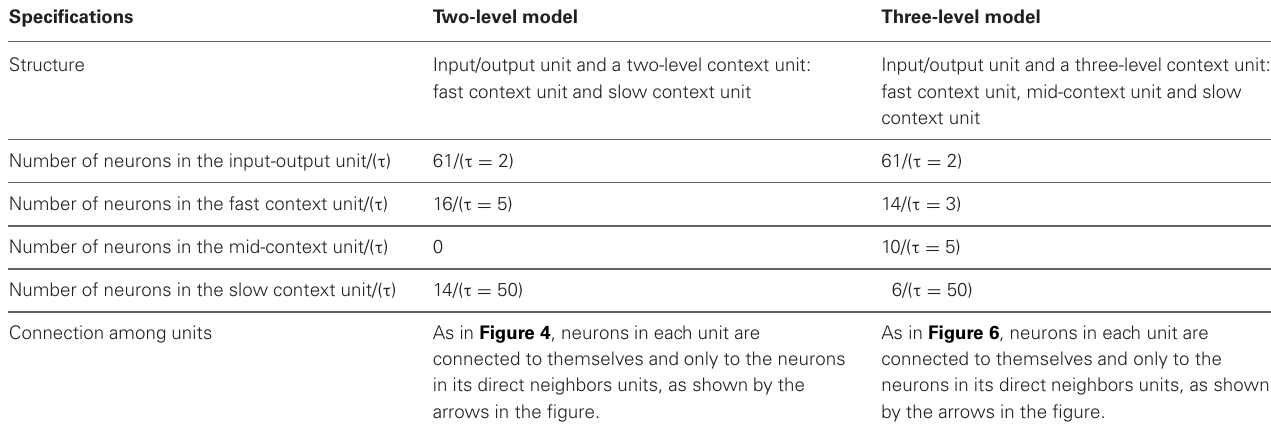
Table 1 | Specifications of the MTRNN